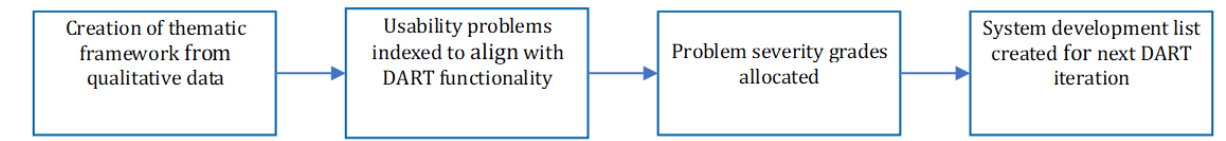
Figure 5. Qualitative data translates into system improvement in the iterative convergent mixed methods design. DART: Digital Assessment Routing